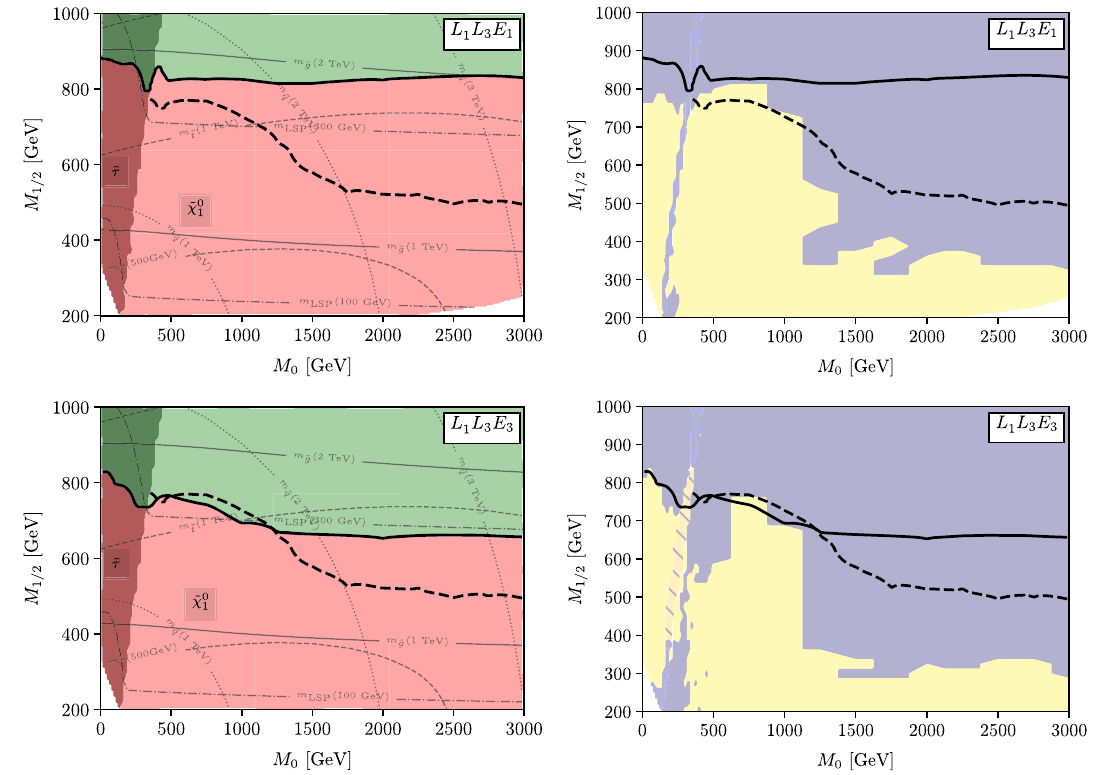
Fig. 13 Same as for Fig. 12, but considering the non-zero operators (in descending order) λ 131 and λ 133 starts dominating the exclusion line for small M 0 . 11 To the right in the lower-left plot, the neutralino-LSP decay now always involves tau leptons, cf. Eq. (18). The resulting over- all bound, the thick solid black curve, is weaker than in the λ 122 case in the neutralino-LSP region, as the multilepton signal is diluted by these taus. However, it is still stricter than the RPC case, the thick black dashed curve. We